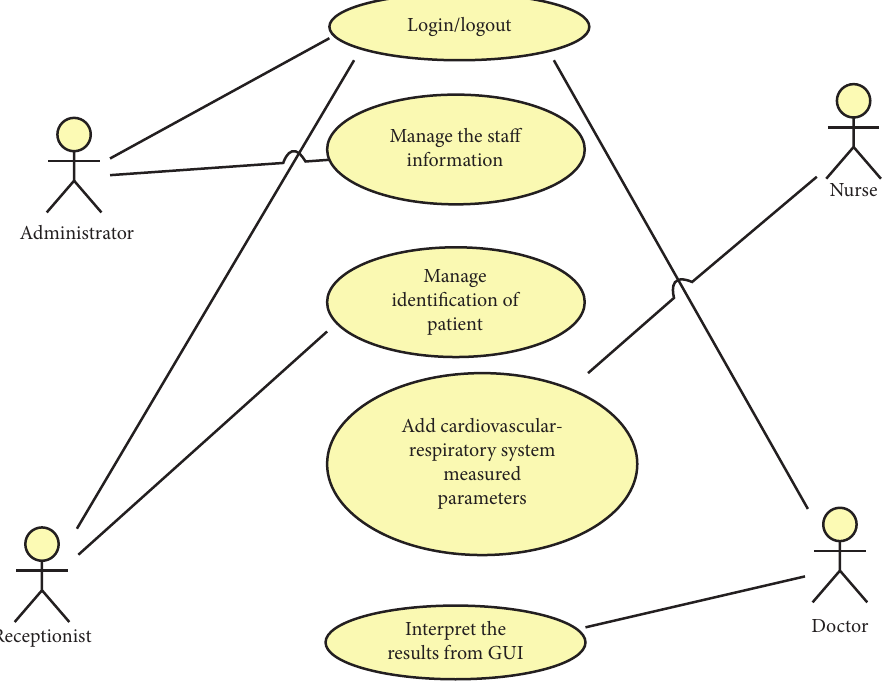
Figure 3: Interaction between medical users and guide user interface of cardiovascular-respiratory system.